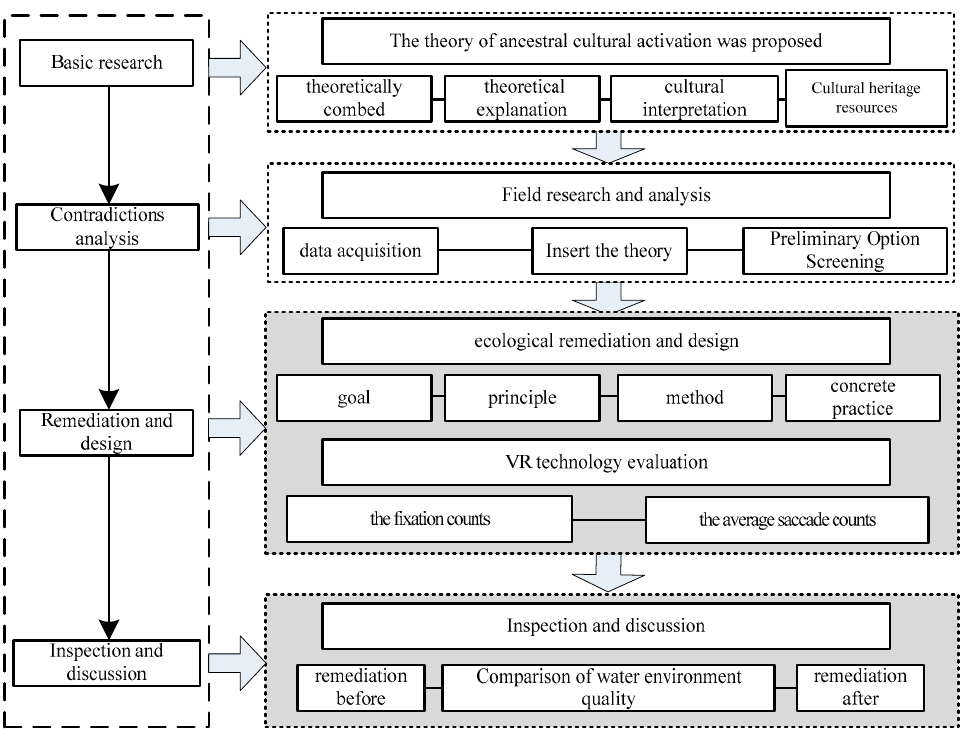
Table 1. Data sources and processing statistics.